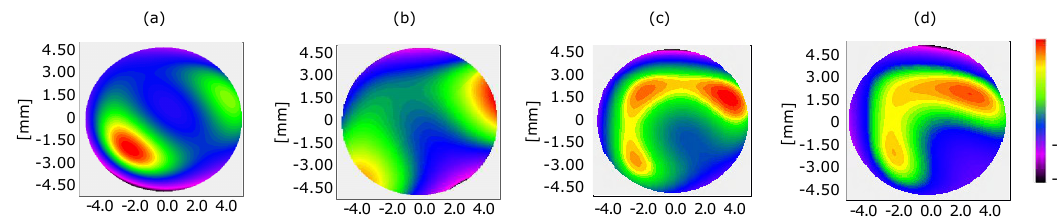
Figure 5. Wavefront map obtained with Fourier demodulation on direct beam by vertically displacing circular area of interest by ( a ) ´ 10 pixels or ´ 0.14 mm, ( b ) 0 mm, ( c ) 10 pixel or 0.14 mm, and ( d ) 30 pixels or 0.39